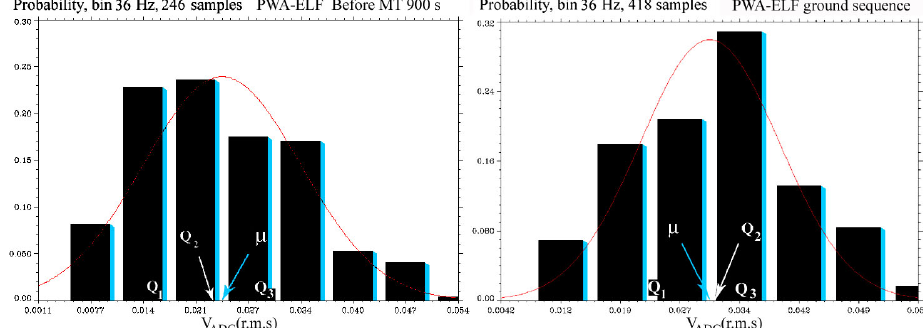
Fig. 4. Amplitude distribution of bin 36 for two sequences for SNR, respectively > 1 (left panel), and < 1 (right